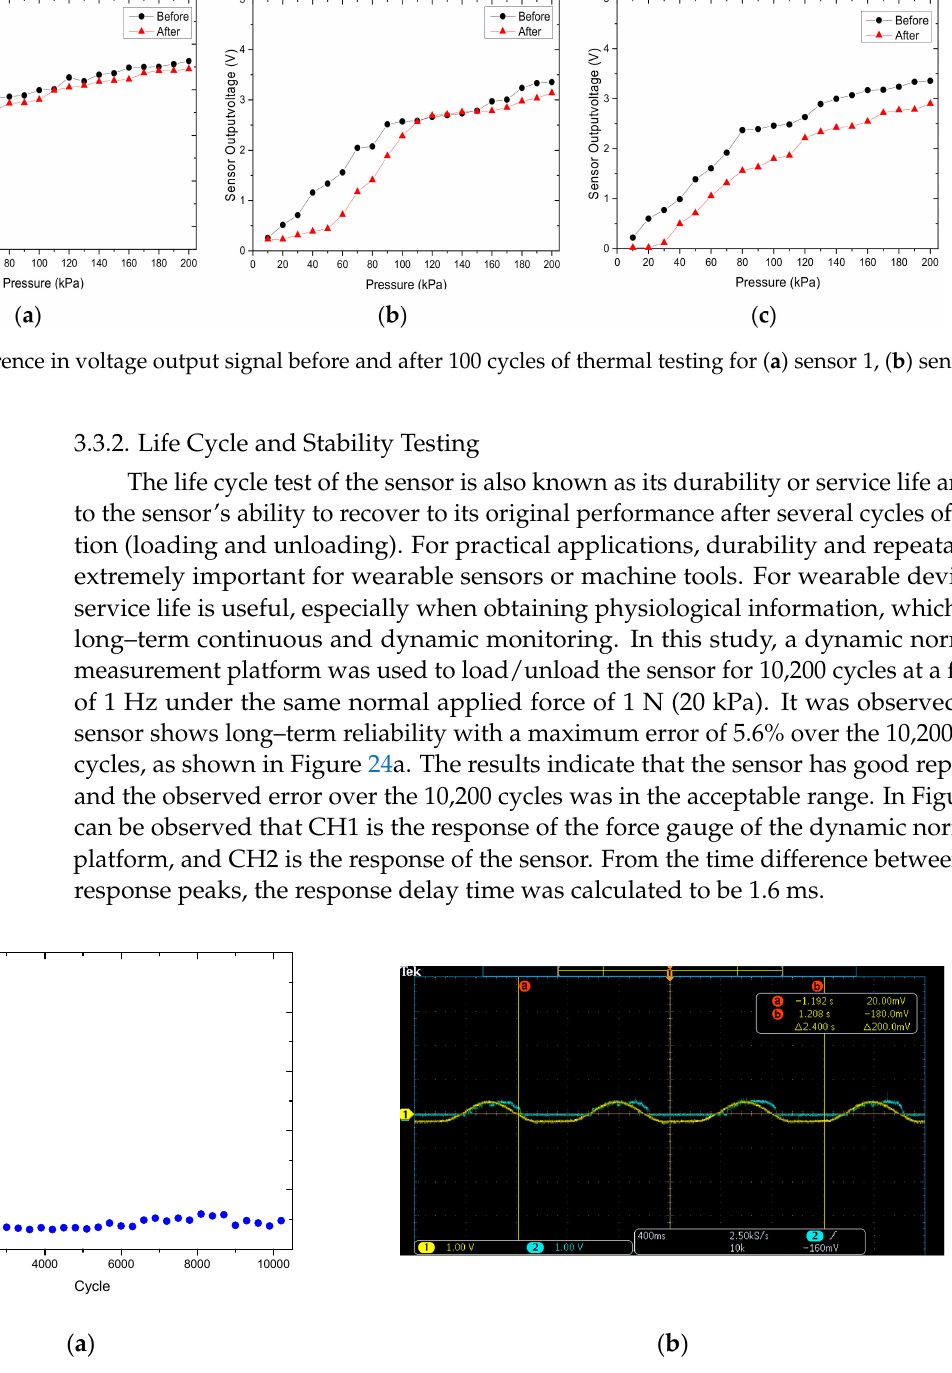
Figure 24. ( a ) Life cycle testing of the sensor and ( b ) the observed response delay